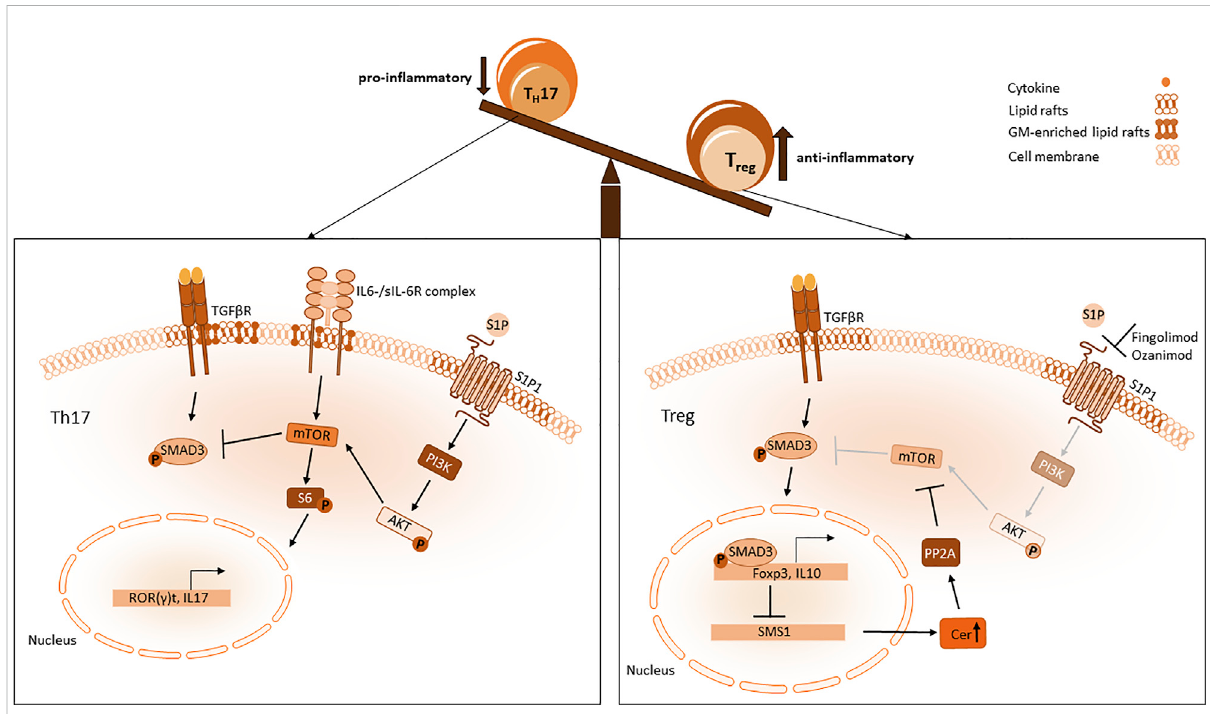
FIGURE 4 Sphingolipid in fl uence on Th17 and Treg imbalance. In a pro-in fl ammatory setting Th17 differentiation is mediated through mTOR which is activated by S1P1 and IL6 Receptor signalling. MTOR activates S6 phosphorylation resulting in a Th17 favouring expression pattern with ROR( γ )t and IL-17 expression. Blockade of Smad3 activity mediated via S1P1 dependent mTOR pathway inhibits Foxp3 expression. When S1P1 is antagonized, mTOR signalling is diminished and activity of Smad3 mediated through the TGF β pathway is sustained. Smad3 enhances Foxp3 expression, which impairs SMS1 transcription resulting in an increased level of ceramides in the cytosol. PP2A interacts with those ceramides and attenuates mTOR